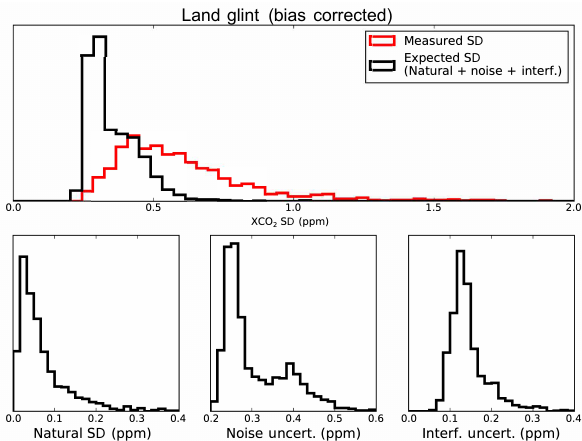
Figure A4. Same as Fig. A2 but for land glint.